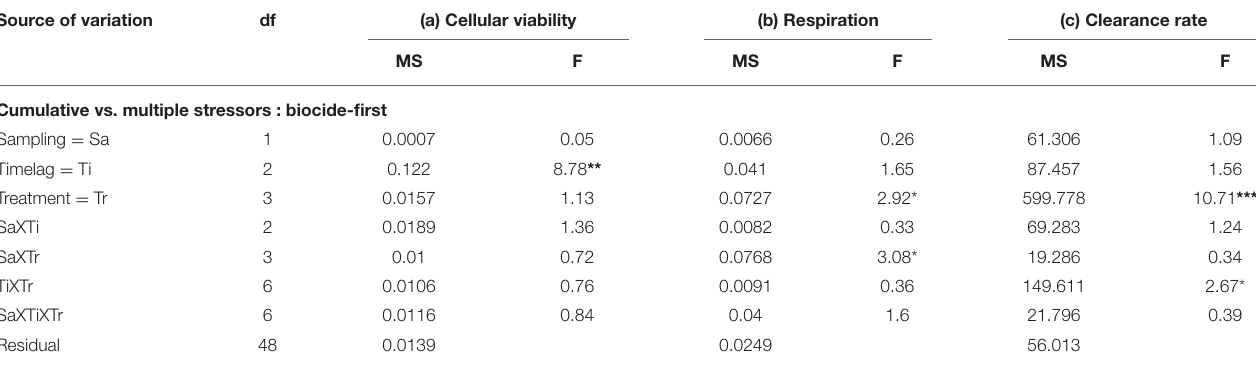
TABLE 3 | Analyses of the (a) cellular viability (optical density g − 1 haemocyte protein), (b) community respiration (mg O 2 l − 1 h − 1 ), and (c) clearance rates (l/h) of mussels/mussel assemblages at Malahide marina comparing cumulative and multiple stressor treatments with biocide as the primary stressor, corresponding to the first and second subsets of treatments described in the Materials and Methods ( n = 3 plots; for all variables: data are untransformed; Cochran’s test: ns). Source of variation df